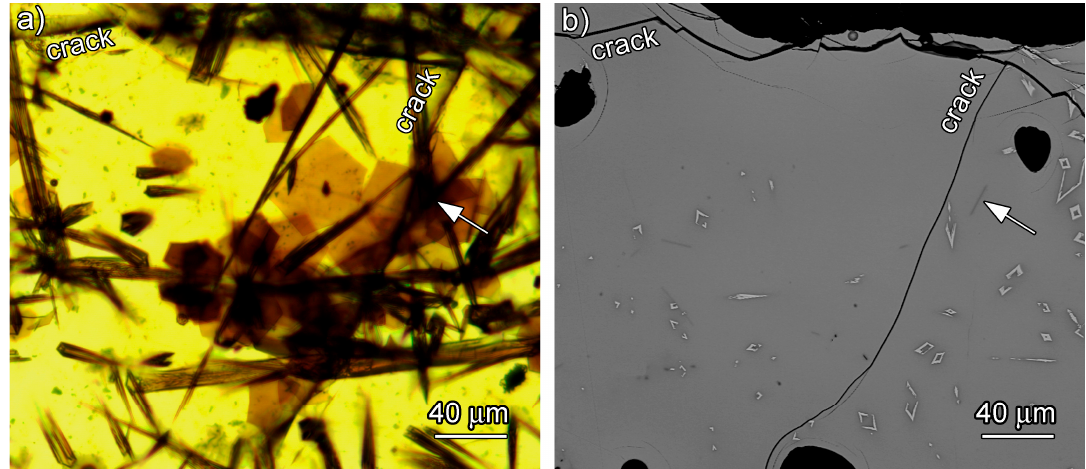
Figure 4. ( a ) A photomicrograph of the ceramic glaze (TL): Hexagonal crystallites are visible and widespread all over the glaze along with acicular melanotekite crystallites. ( b ) A BSE image of the same area as in Figure 4a. As we can see, the microstructural information has gone completely lost: only scarce and very thin grey laminar sections of the hexagonal crystallites are visible (e.g., as indicated by the arrow) along with sections of melanotekite crystals (head arrow shaped crystals in lighter tones). The images are adapted from Di Febo et al., 2018 [37].